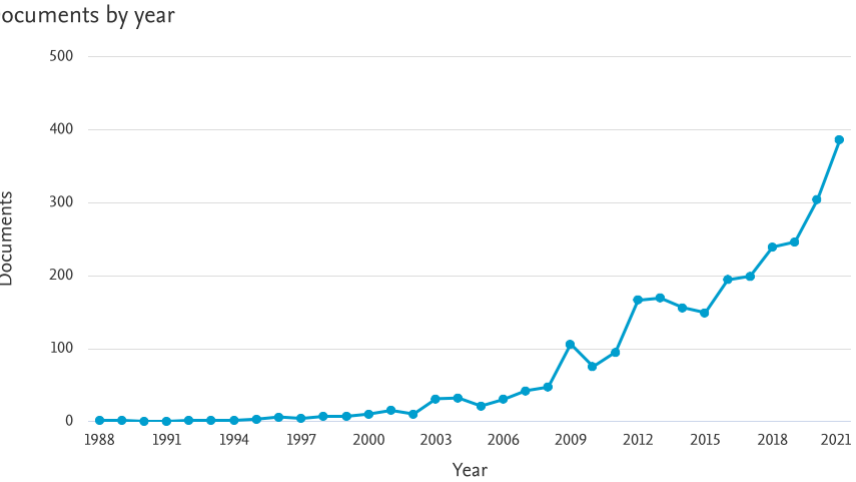
Figure 1. Number of scientific articles on climate policy co-benefits in 1988–2021. Source: SCOPUS, 30 November 2022 (see Supplementary Material).